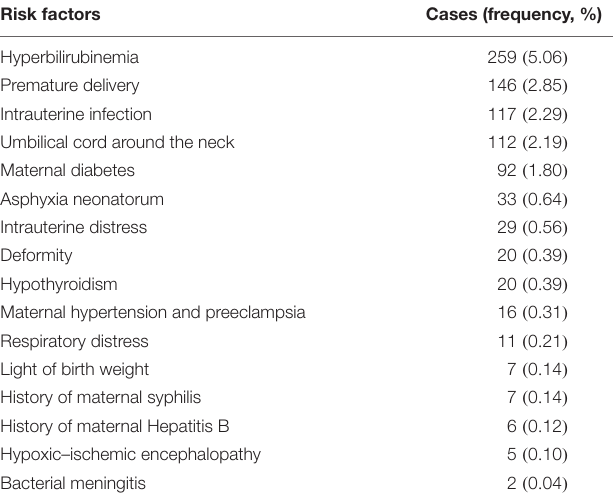
TABLE 3 | 278 GJB2 variants and genotypes.